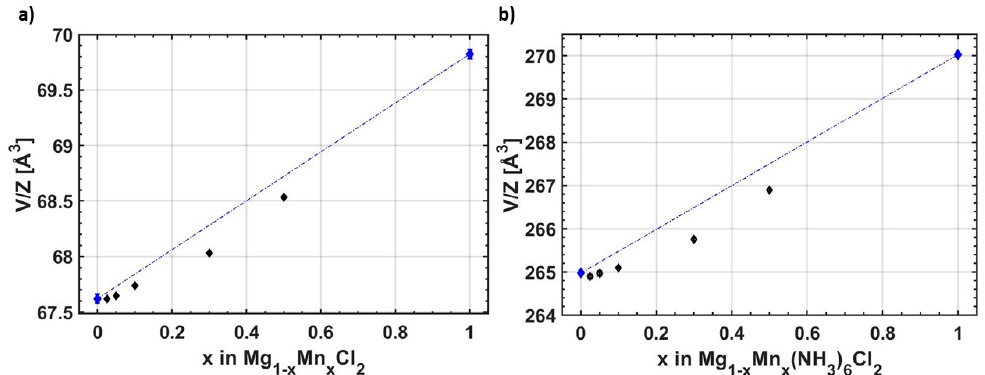
Figure 2. Unit cell volumes (V) of ( a ) Mg 1 − x Mn x Cl 2 and ( b ) Mg 1 − x Mn x (NH 3 ) 6 Cl 2 at RT divided by the number of formula units (Z), plotted as a function of the Mn amount in the formula unit (x = 0, 0.025, 0.05, 0.1, 0.3, 0.5 and 1). The blue dotted line represents Vegard’s law. The standard deviations are within the data points.